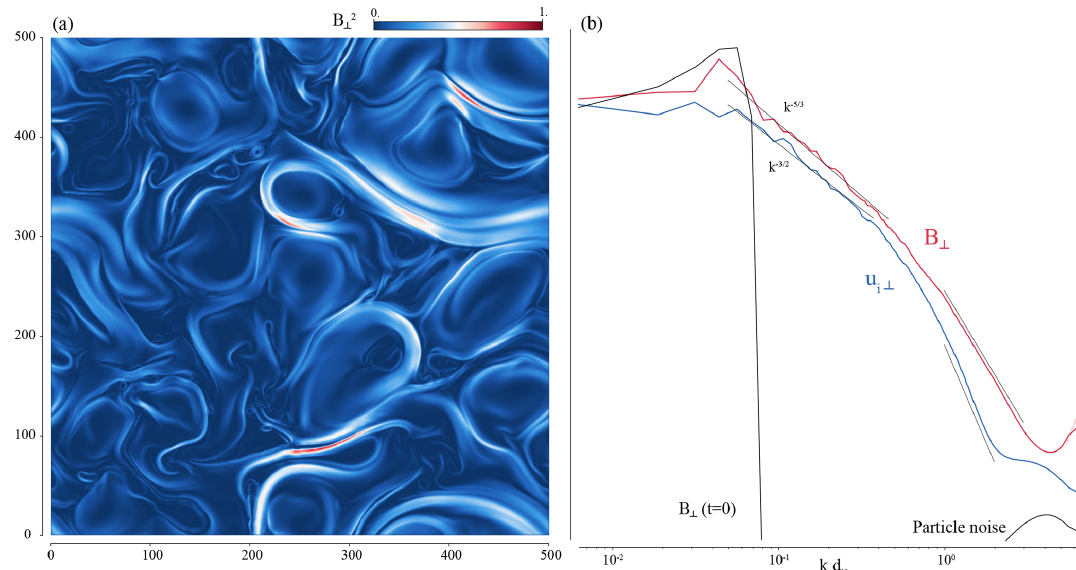
Figure 4. Decaying turbulence at time 500 ω − 1 . (a) shows the squared in-plane (perpendicular) magnetic field amplitude, while (b) presents ci 0 the omnidirectional power density spectra of the same perpendicular magnetic field as well as the perpendicular velocity